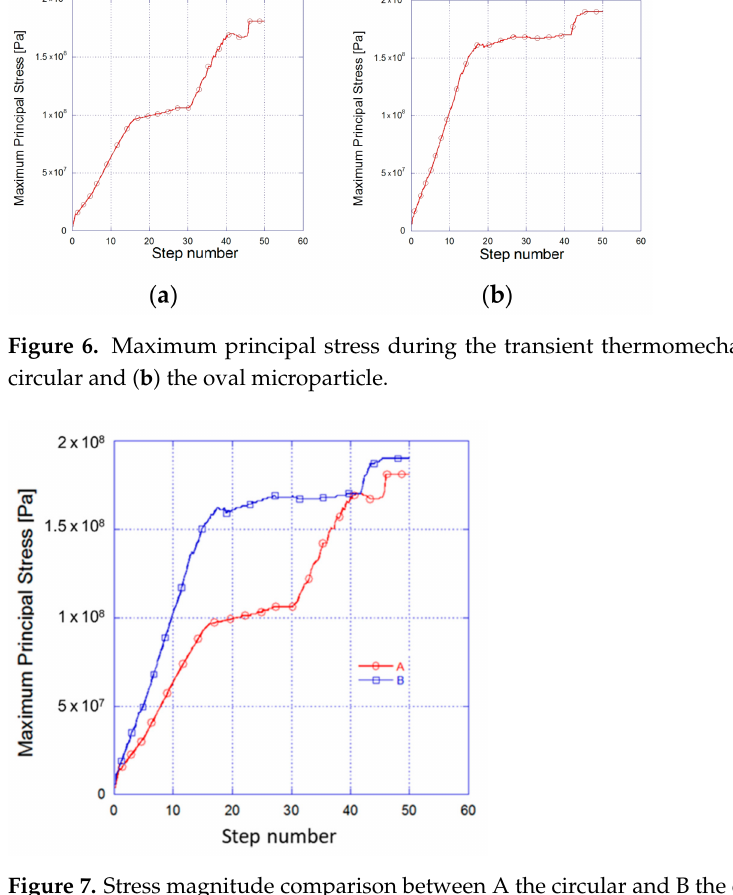
Figure 7. Stress magnitude comparison between A the circular and B the oval